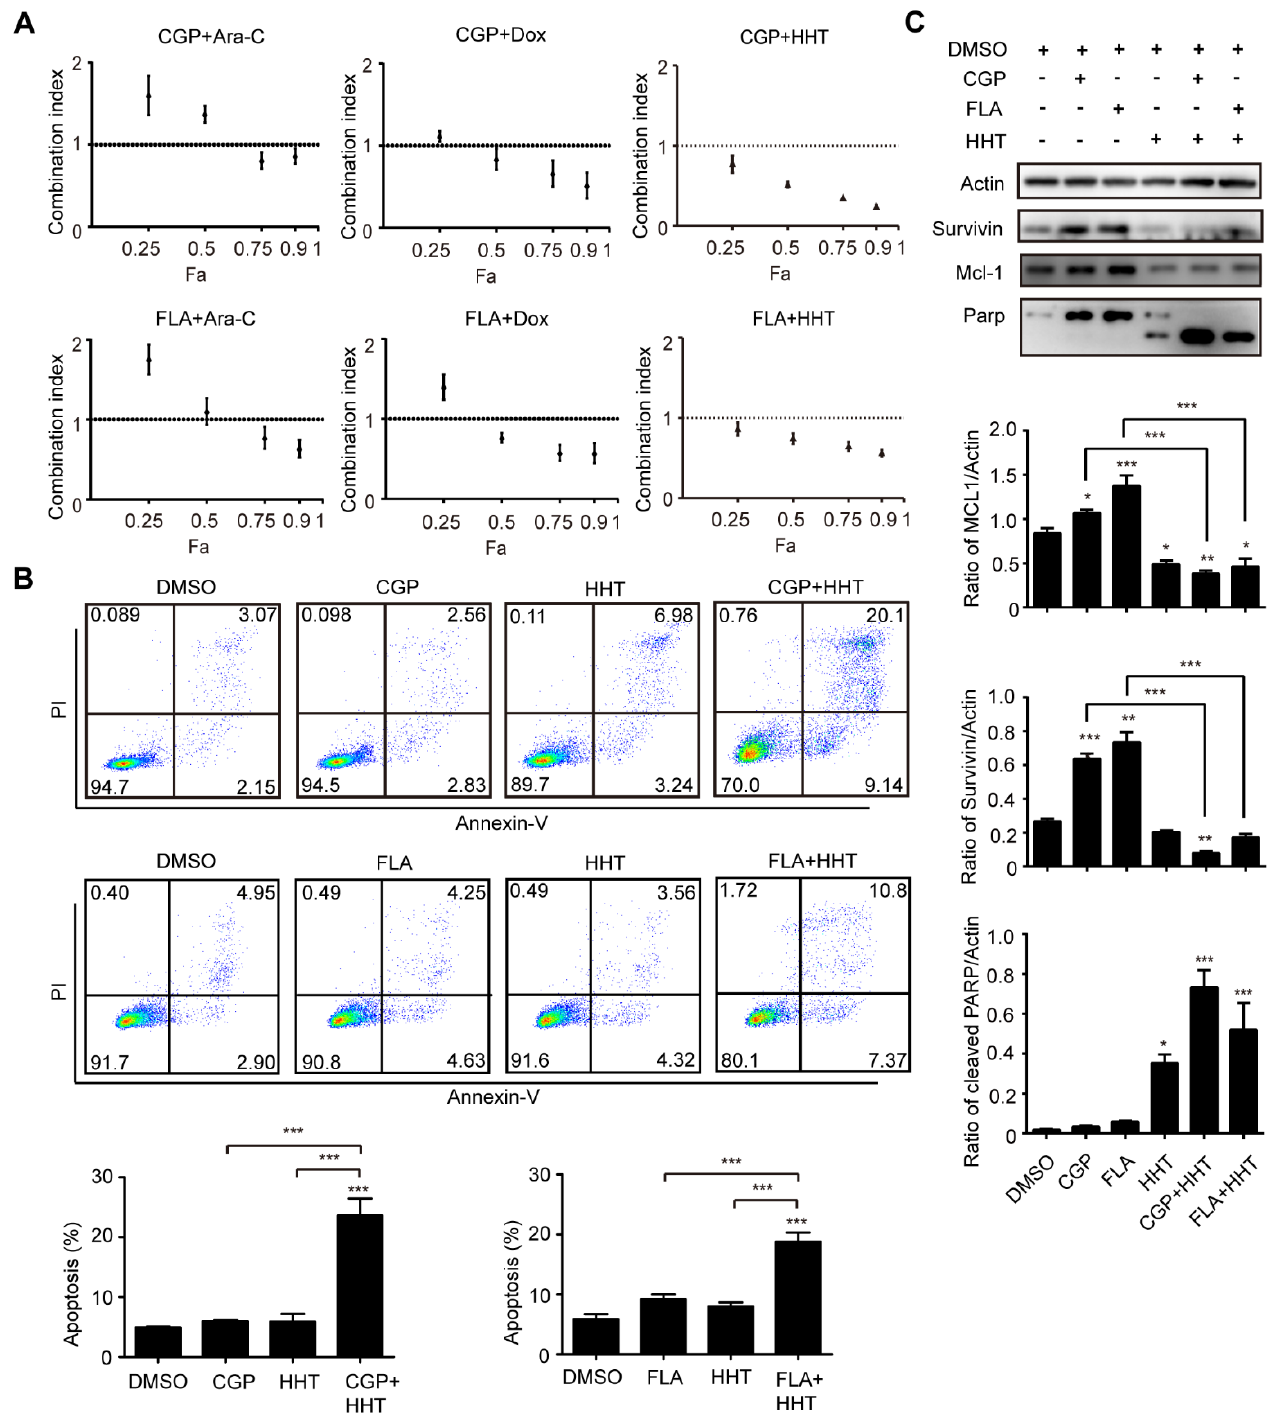
Figure 6. CGP and FLA show strong synergy with HHT in OA3 cells. ( A ) Combination Index plots obtained from OCI- AML3 cells exposed simultaneously to chemotherapy drugs (Ara-C, Dox, or HHT) and CDK1 inhibitors (CGP or FLA) for 24 h as indicated. ( B ) The apoptosis analysis of OA3 with different treatments of CGP, FLA, and HHT for 24 h as indicated. ( C ) Western blotting analysis for the apoptosis-related protein (Parp, MCL-1, and survivin) in OA3 cells treated with CGP, FLA, and HHT for 24 h as indicated. Data are presented as mean ± SD, * p < 0.05, ** p < 0.01, *** p < 0.001.